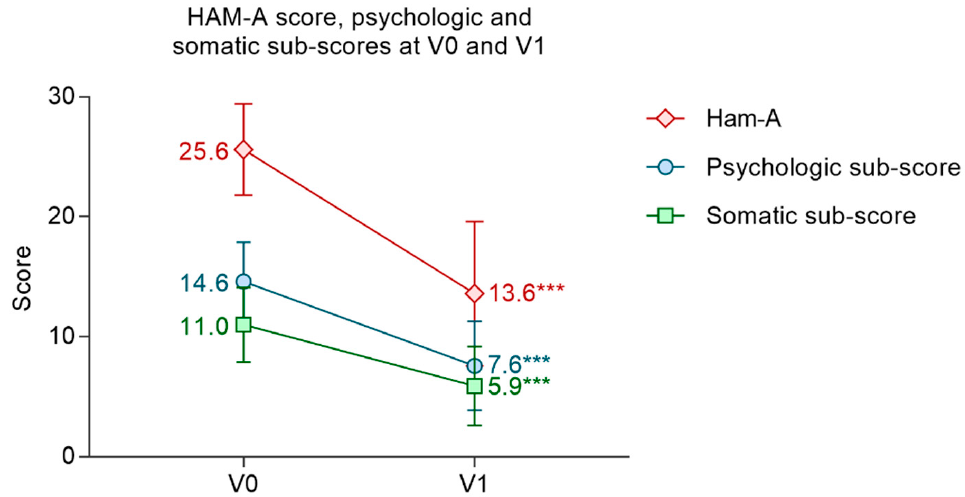
Figure 3. Evolution of the Ham-A score and psychologic and somatic subscore between V0 and V1. Ham-A variation: Student’s t -test; psychological subscore variation: Wilcoxon signed-rank test; so- matic subscore variation: Student’s t -test. Mean ± SD. *** p < 0.001.